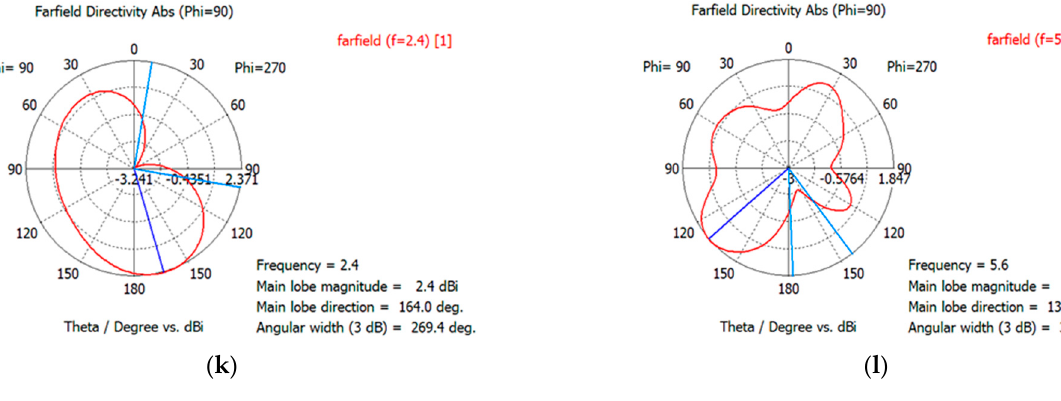
Figure 4. ( a – c ) Comparison of S11 of the three antennas around 400 MHz, 2.4 GHz, and 5.6 GHz. (Antenna I __ _, Antenna II ______, Antenna III _ _ _ _). ( d – f ) Patterns of the Antenna I in three bands. ( g – i ) Patterns of the Antenna II in three bands, and ( j – l ) Patterns of the Antenna III in three bands.